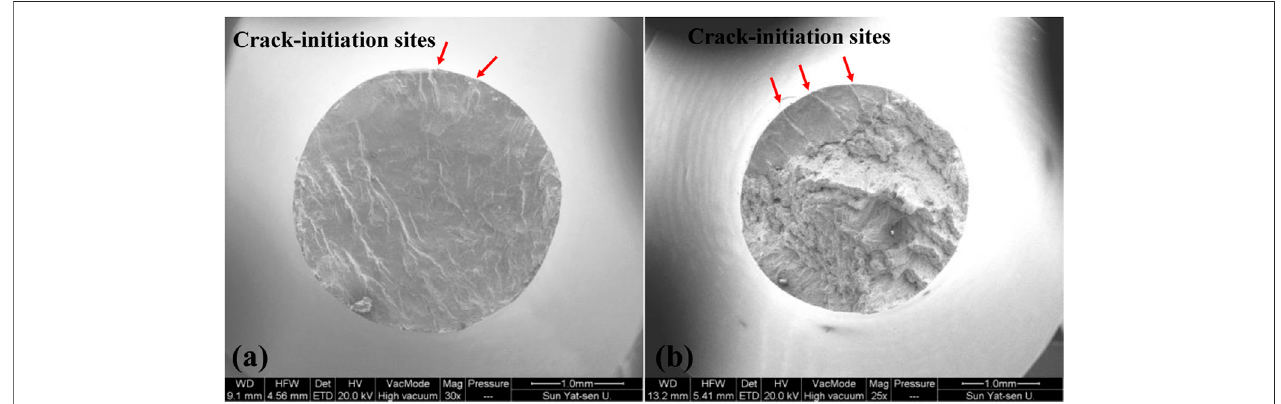
FIGURE 4 | Fracture surface of the specimens (GTAW) (A) failed under 320 MPa at 1.53 × 10 5 cycles (Xiong et al., 2019b) (B) failed under 250 MPa at 4.3 × 10 7 cycles.